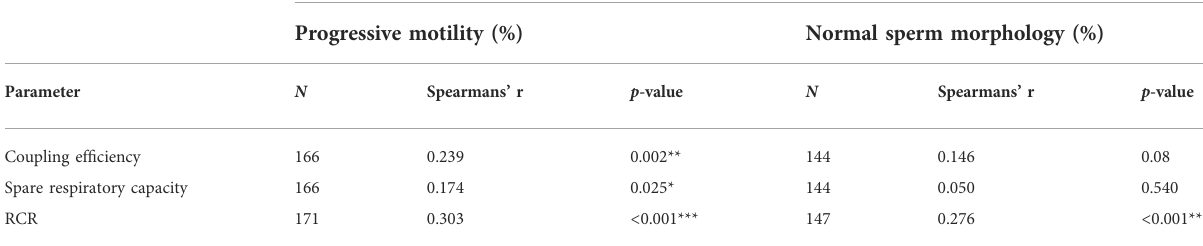
TABLE 2 Correlation between sperm parameters and mitochondrial indices. Coupling ef fi ciency = ATP turnover/basal respiration. Spare respiratory capacity = maximal respiration rate/basal respiration. RCR = maximal respiration in the presence of FCCP/respiration in the presence of oligomicyn, N = number of donors. Statistical analysis was evaluated using Spearman ’ s test * p < 0.05, ** p < 0.01, *** p <